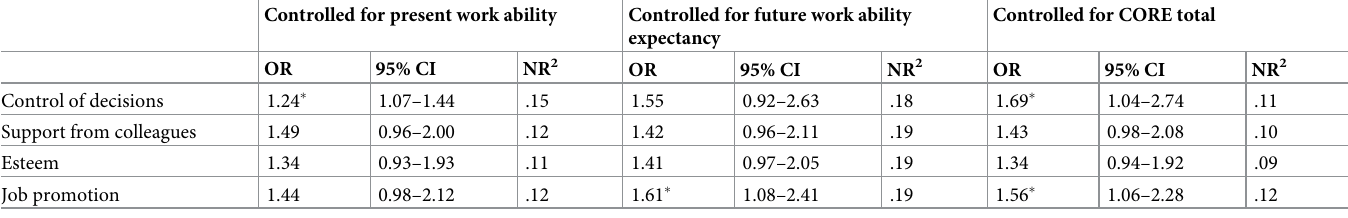
Table 4. Psychosocial work factors at baseline predicting RTW in a series of logistic regression analyses: controlled for present work ability, expectancy of future work ability, and CORE